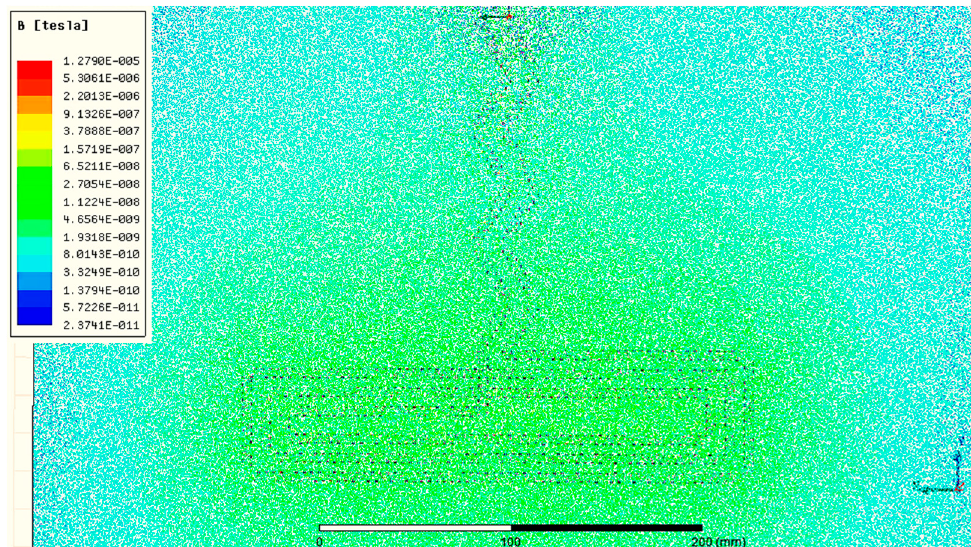
Figure 5. Simulation of the electromagnetic field created by the sensor.